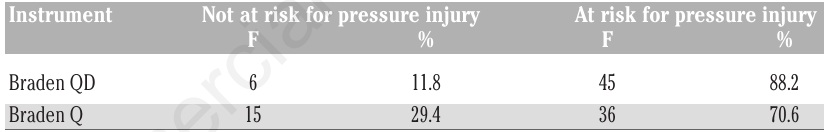
Table 2. Distribution of participants based on pressure injury by using Braden QD Scale and Braden Q Scale in PICU.